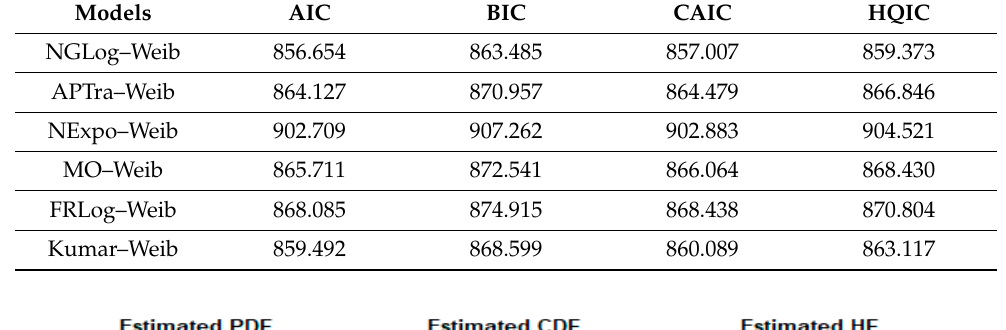
Table 8. The DMs of the competing models for infected guinea pigs data (dataset 1).